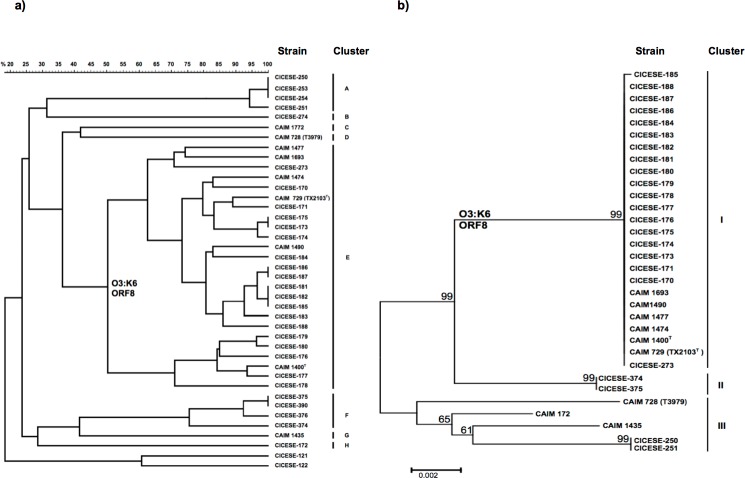
Dendrograms of CICESE and CAIM V. parahaemolyticus O3:K6 strains for: a) the neighbor-joining tree (UPGMA) by PFGE analysis after digestion with NotI and b) the neighbor-joining tree (Kimura’s 2 parameters) by MLST of the concatenated sequences of 7 loci.